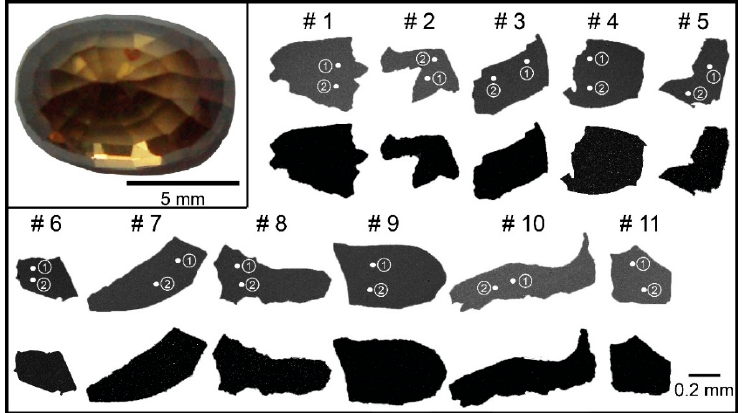
Figure 1. A photograph of the LKZ-1 zircon (inset) and representative backscattered electron (upper) and cathodoluminescence (lower) images. The grain and spot numbers are the same as in Table 2.